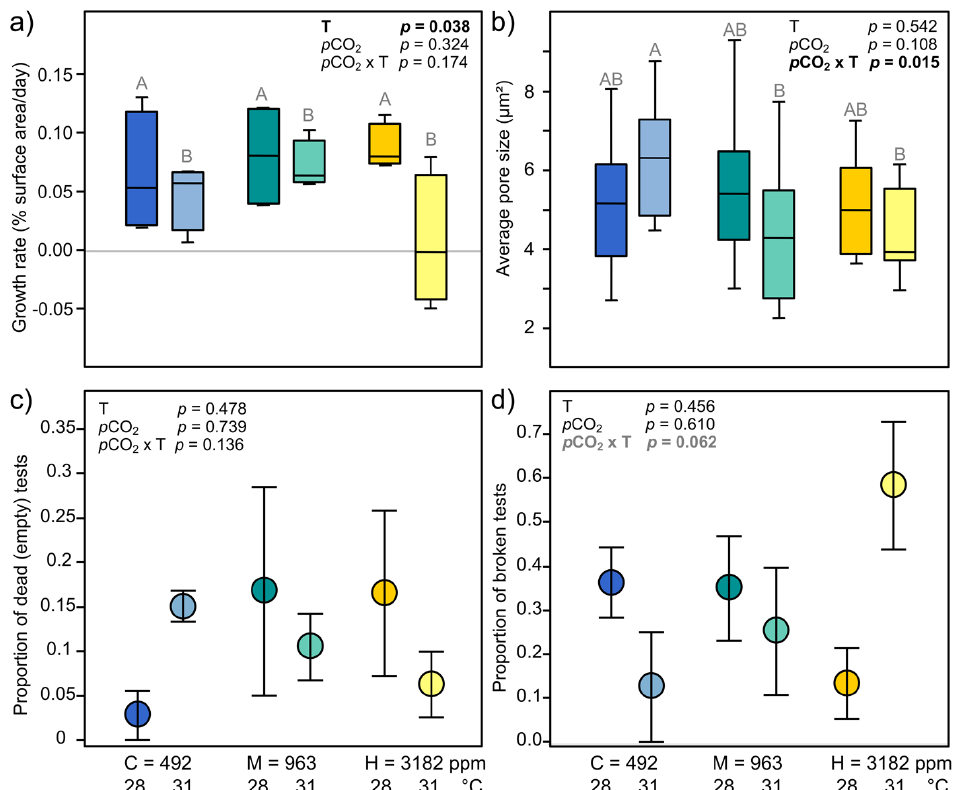
Figure 3. Changes in key physiological parameters of the Amphistegina lobifera host in response to elevated p CO 2 (C = 492 ppm, M = 963 ppm, H = 3182 ppm) crossed with temperature (28 °C, 31 °C): ( a ) growth rate calculated as the daily %-change in total surface area (n = 4), ( b ) average pore sizes of the terminal chambers of their tests (n ≥ 8), ( c ) mortality represented by proportion of dead (empty) tests, resulting from age-, stress-, and/or reproduction-induced death, and ( d ) breakage represented by frequency of broken specimens, probably due to reduced test strength. ( a , b ) Box plots indicate median and interquartile ranges, with total ranges represented by vertical bars. Two-way ANOVA p- values are given, with bold values indicating significant effects ( p ≤ 0.05). Treatments lacking common capital letters are significantly different in the respective post-hoc multiple comparison (Tukeys’ HSD test). ( c , d ) Dot-and-whisker plots indicate means and standard errors. Logistic model p -values for frequency data are given, with marginal significance indicated by grey.